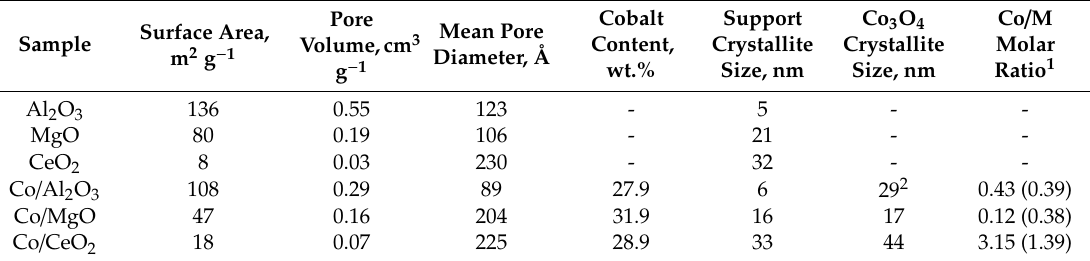
Table 1. Textural properties of the supports and the supported cobalt catalysts.